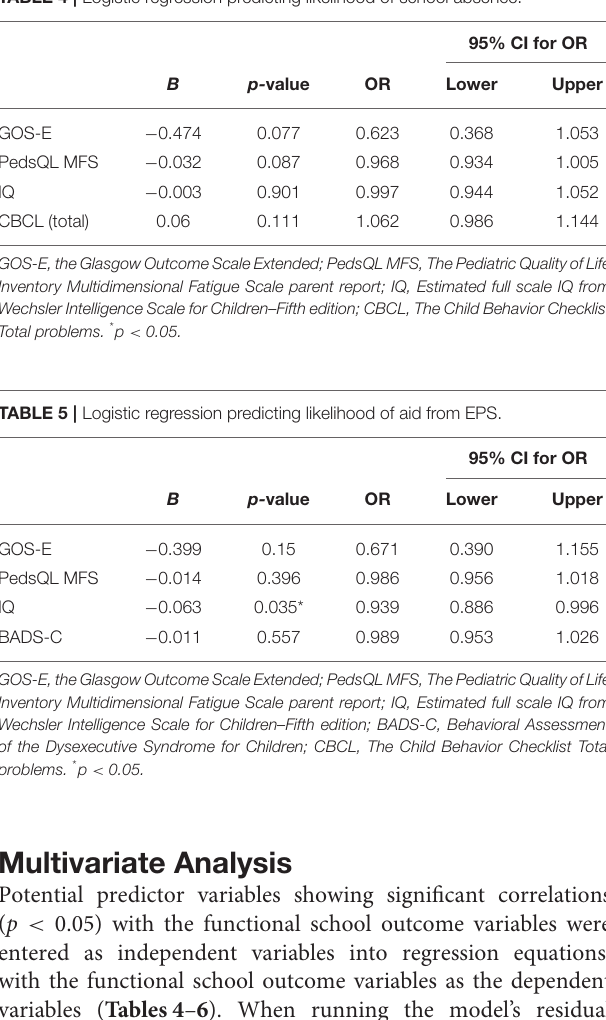
TABLE 4 | Logistic regression predicting likelihood of school absence.